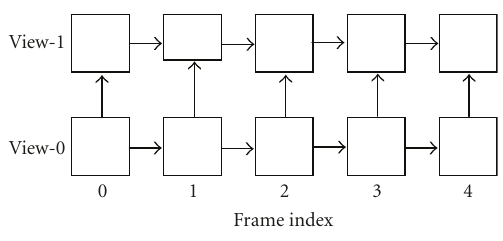
Figure 7: Sample prediction structure for two views.